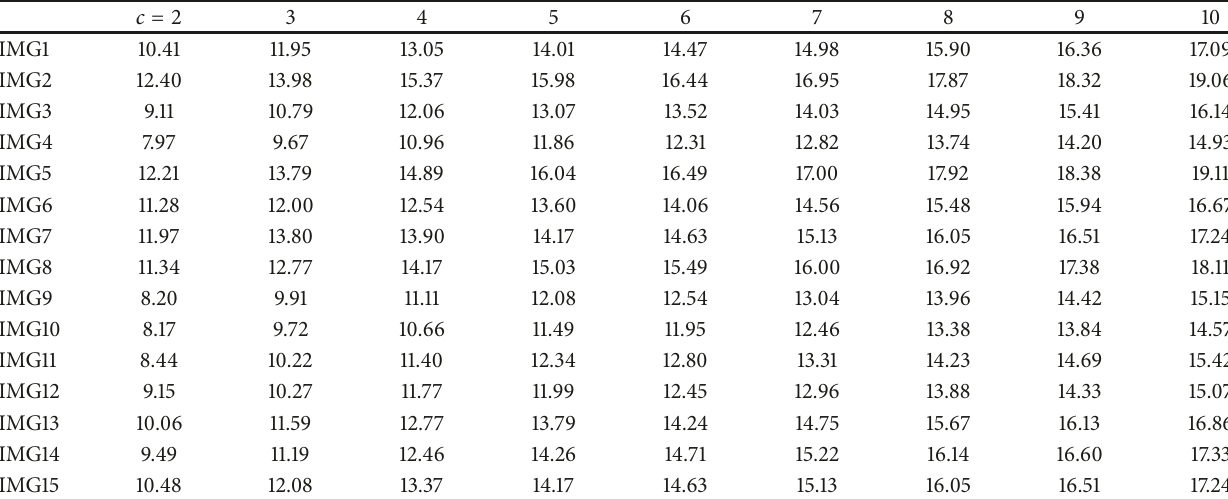
Table 11: PSNR using FCM with different cluster